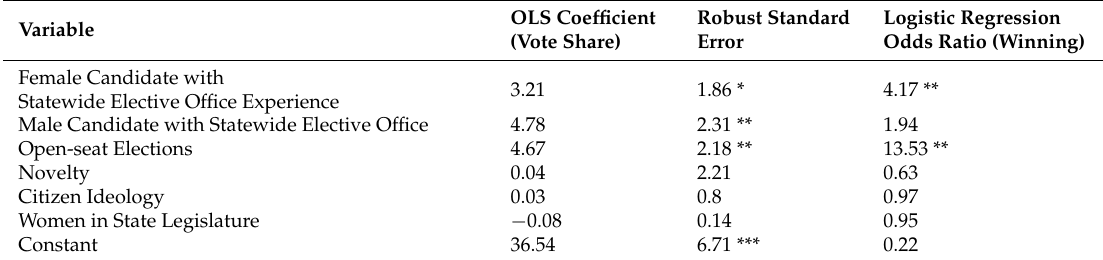
Female Electoral Success = a + Female Candidate with Statewide Office Experience + Male Candidate with Statewide Office Experience + Open-seat Elections + Novelty + Citizen Ideology + Women in the State Legislature. Table 2. Vote for female gubernatorial candidates running as challengers or in open-seat elections, 1976–2014. OLS Coefficient Robust Standard Logistic Regression Variable (Vote Share) Error Odds Ratio (Winning) Female Candidate with Statewide Elective Office